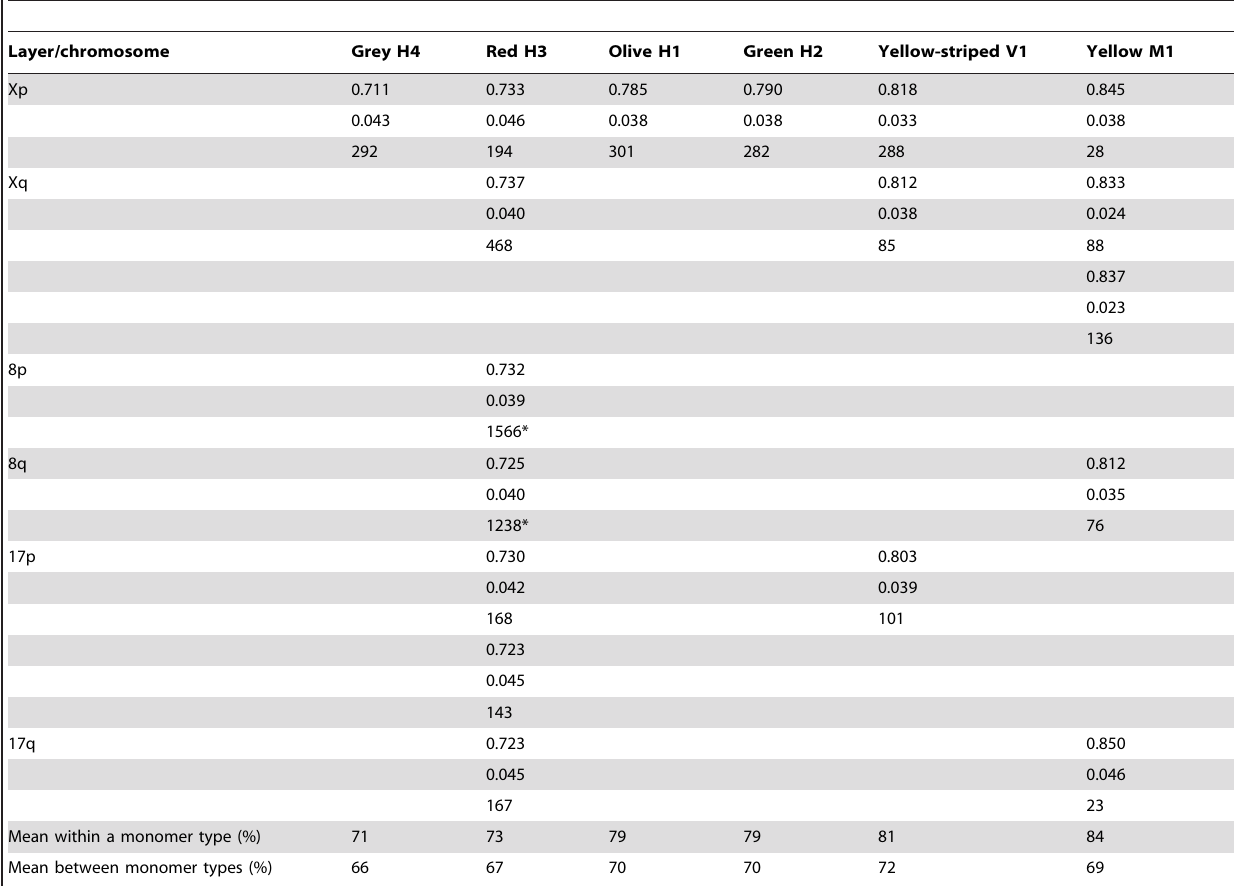
Table 3. Average identity of monomers in AS layers.